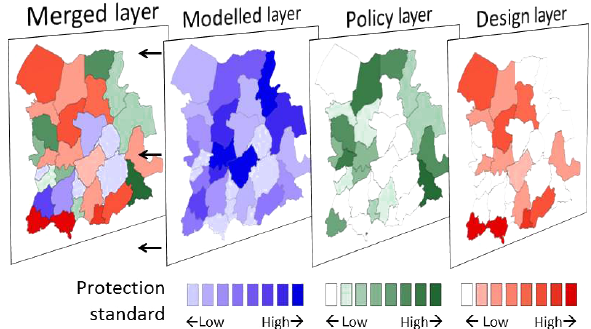
Figure 2. Procedure for the integration of protection standards in- formation from the design, policy and model layers into the merged layer of the FLOPROS